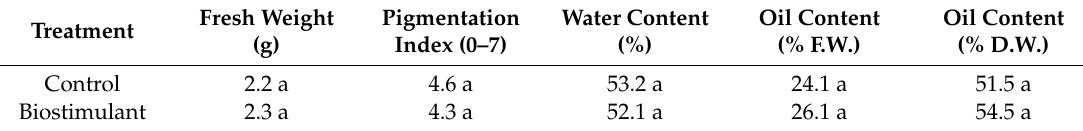
Table 2. Fruit characteristics at harvest of young treated and control trees in the